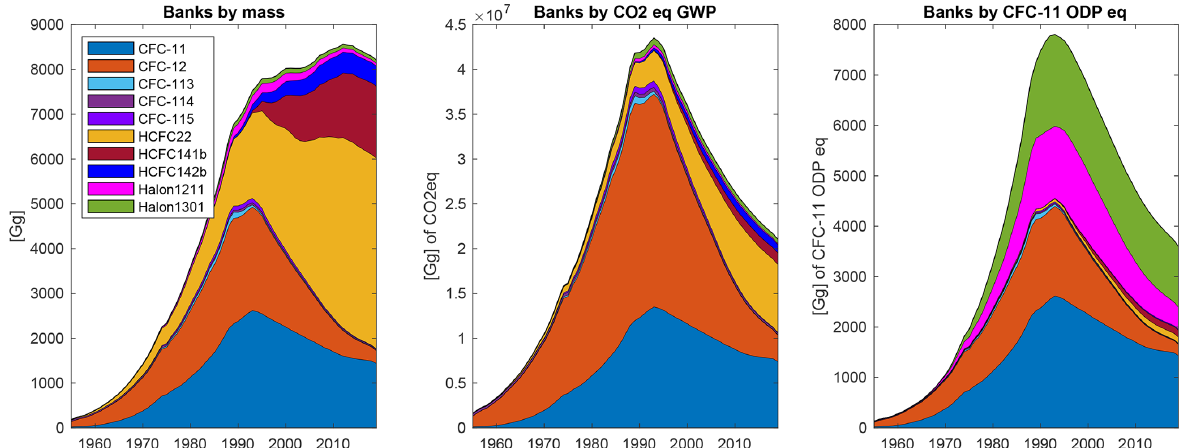
Figure 5. Total banks by mass, global warming potential (GWP100; WMO, 2018), and ozone depleting potential (ODP; WMO, 2018). Bank estimates reported in the above figures are the median estimates from the Bayesian analysis.